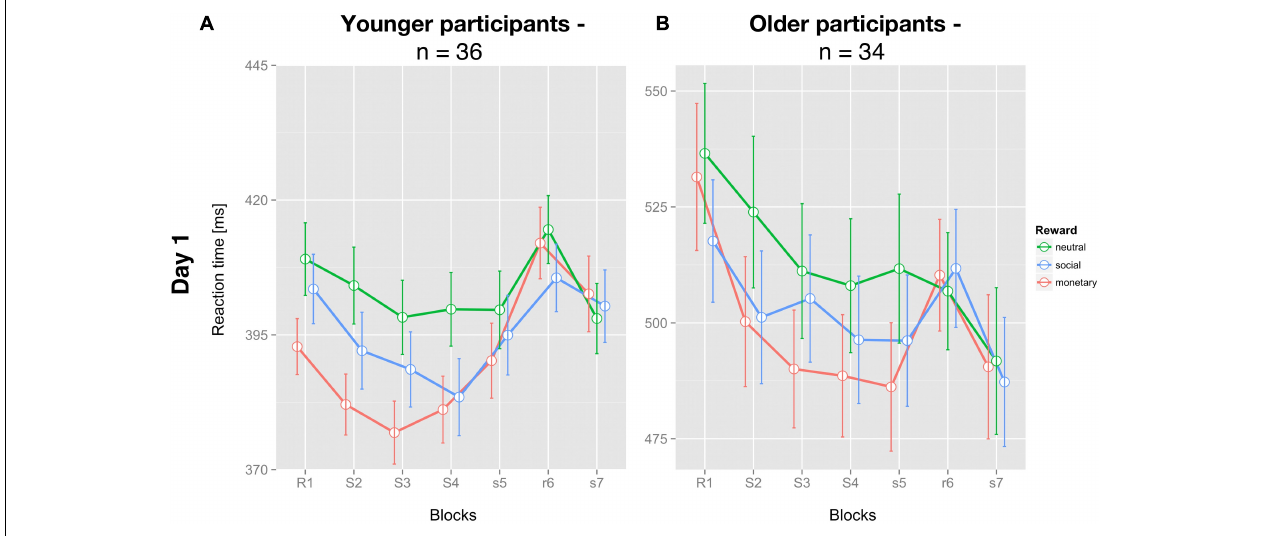
FIGURE 2 | Average reaction times of the SRT paradigm for each reward condition and both groups on day one. (A) Mean reaction time of young ( n = 36) and (B) older ( n = 34) participants for each condition and block ( ± SEM) are depicted for all three feedback conditions: neutral feedback (green), social reward (blue), and monetary reward (red). Capital letters identify blocks with feedback, small letters blocks without feedback. S/s identifies blocks with a repetitive sequential pattern, R/r blocks with pseudo-random